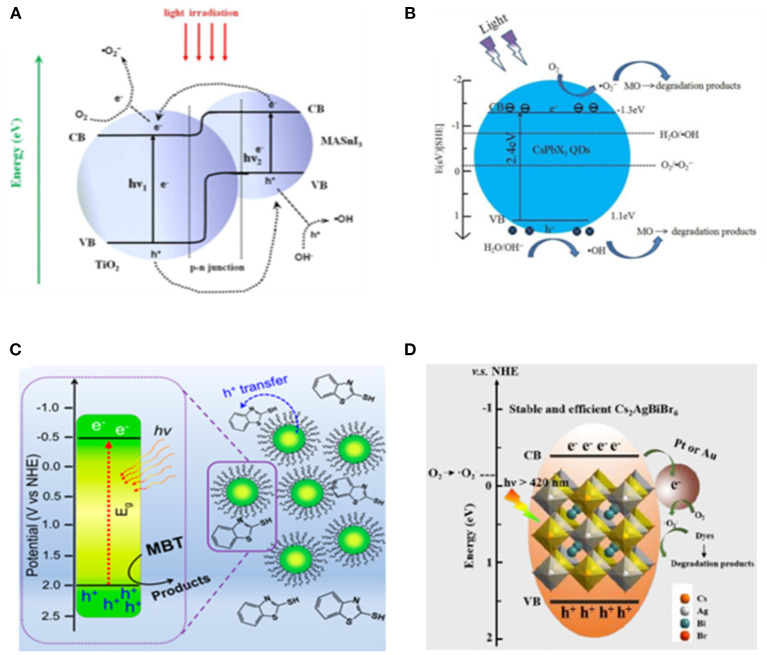
(A) Scheme of photoexcitation of the MASnI3/TiO2 (1:9) heterojunction composite and the subsequent photogenerated carrier transfer process. Reproduced by permission of The Royal Society of Chemistry. (B) Proposed mechanisms for the photocatalytic reaction of MO using CsPbX3 QDs. Reproduced by permission of The Royal Society of Chemistry. (C) Schematic diagram of dye degradation photocatalysis. Copyright © © 2019 American Chemical Society. (D) Schematic diagram of dye degradation with Cs2AgBiBr6 loaded with Pt or Au. © © 2019 Wiley-VCH Verlag GmbH & Co. KGaA, Weinheim.